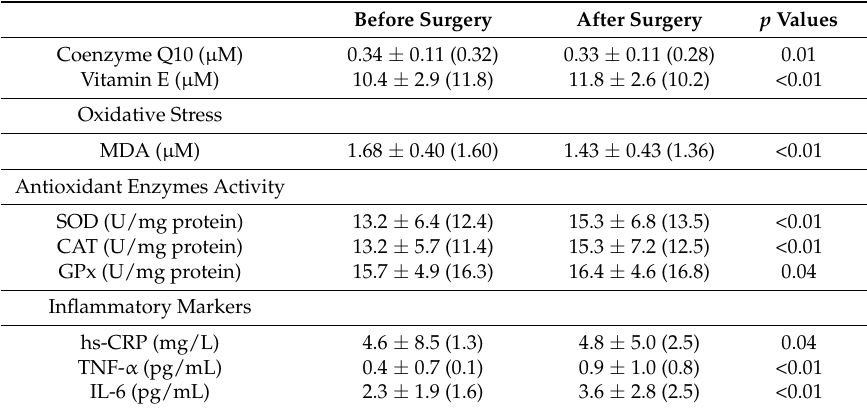
Table 2. Levels of coenzyme Q10, oxidative stress, and inflammation 1